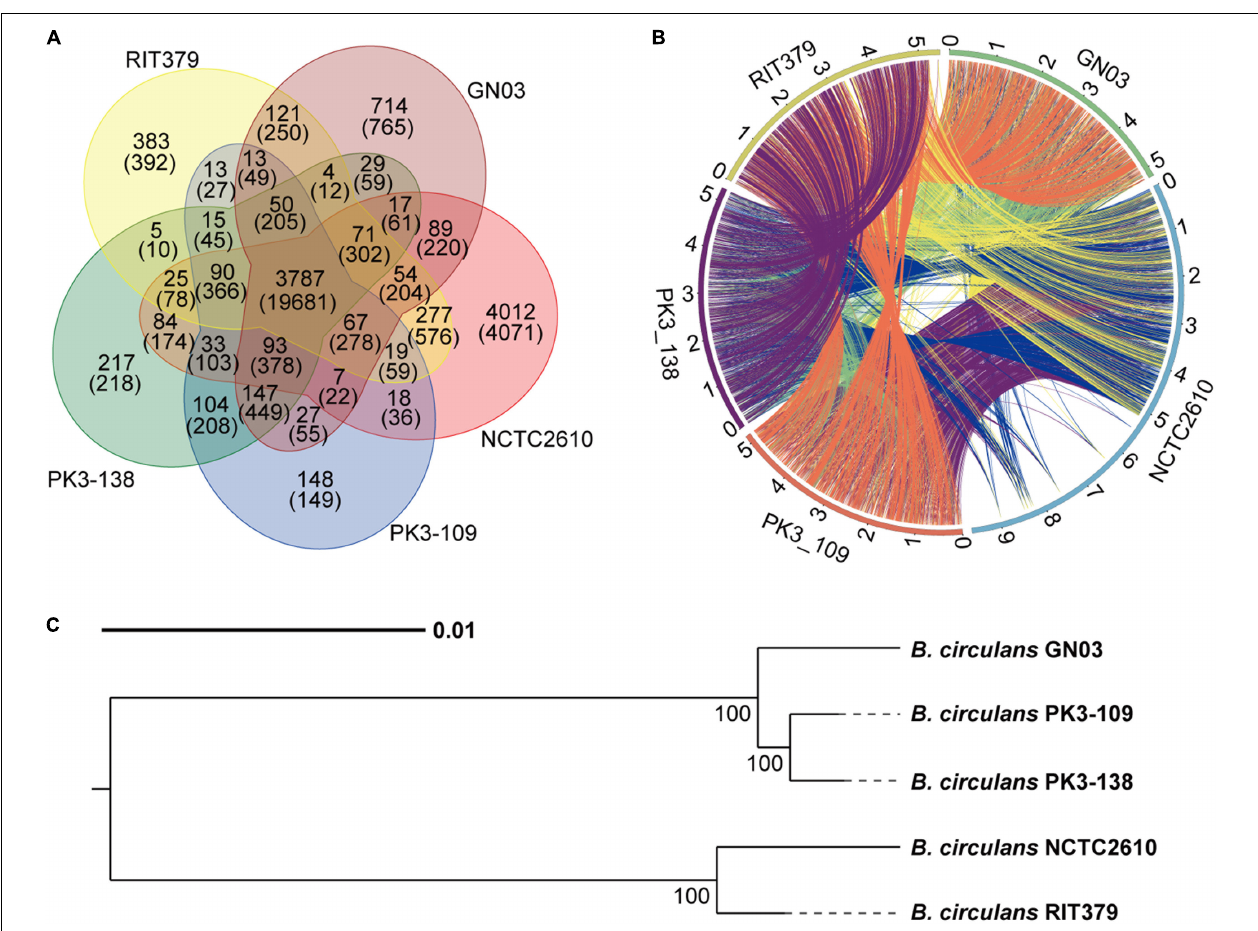
FIGURE 6 | Comparative genomic analysis of GN03 with other four Bacillus stains. (A) Venn diagram showing the number of genes in all five strains. In BLAST alignment, gene pairs with E -values less than 1e-7 are considered to be homologous. OrthoMCL was used to group the homologous genes into the same families. The upper number represents the number of gene families and the lower number represents the number of genes. (B) The collinear circos diagram of the five bacterial strains. The outermost circle represents the genomic sequences of the five bacteria. For example, green in the upper right corner represents the genomic sequence of GN03 bacteria. Every two strains are connected by a line representing a collinear area between the two bacteria. (C) Phylogenetic tree of the five strains. The tree was built using a single copy homologous gene using the neighbor joining method with a bootstrap value of 1,000. Unit: nucleotide substitution